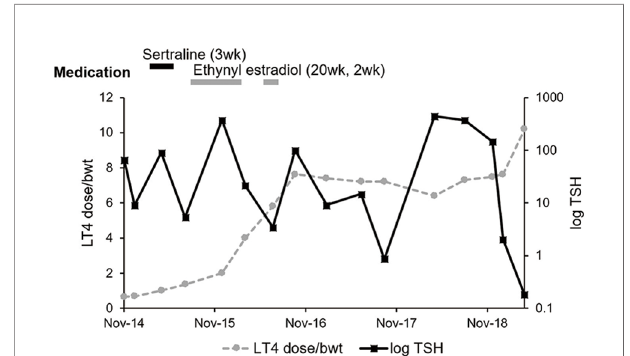
FIGURE 1 | Medical history, log TSH, and LT4 dose per bodyweight of the case patient. The dose of sertraline and ethynyl estradiol were 50 mg per day and 0.03 mg per day, respectively. The beginning dates of each medication were May 2015, September 2015, and September 2016. There was fl uctuation of serum TSH level in spite of increasing LT4 dose over bodyweight. LT4, levothyroxine; Bwt,